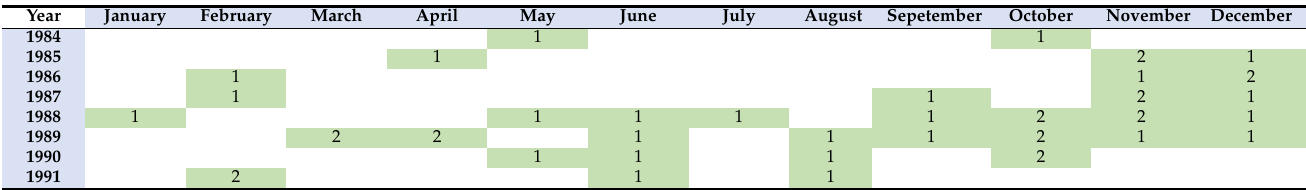
Table A1. Valid Landsat images in the period of